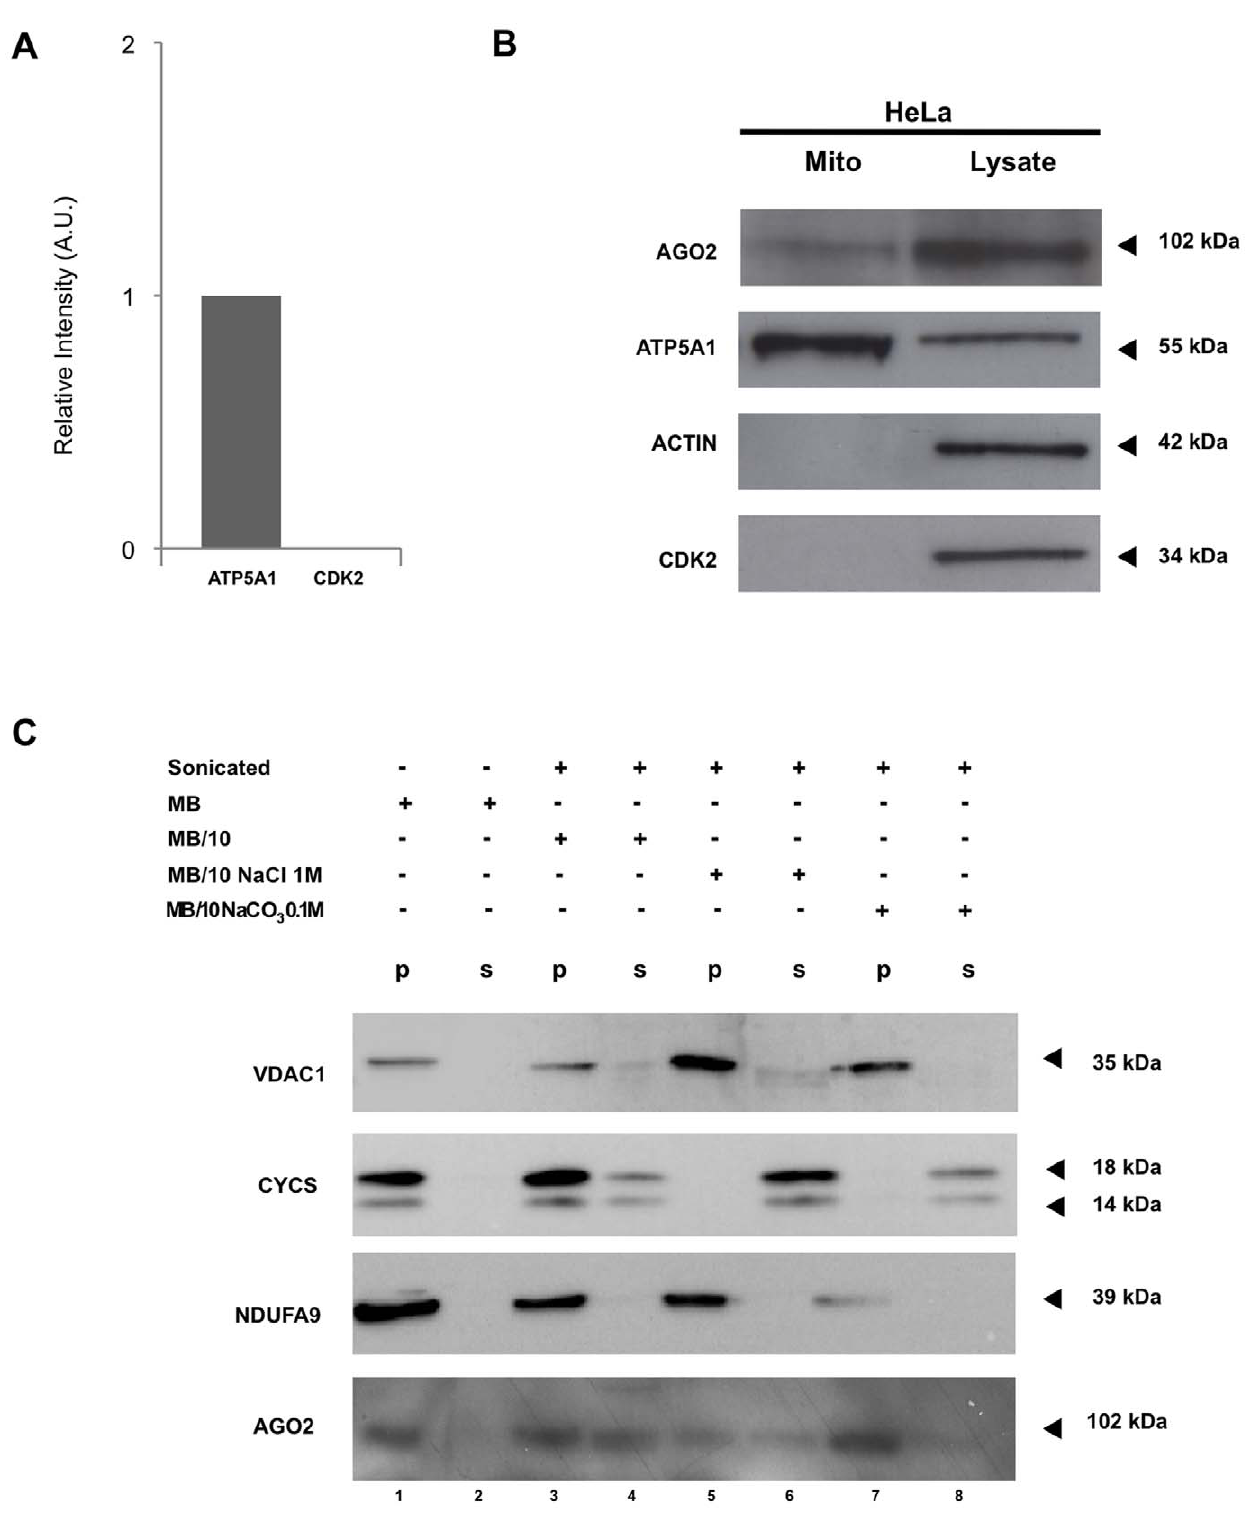
Figure 1. Novel localization of Argonaute 2 (AGO2) to human mitochondria. A. Purity assessment of mitochondrial fraction. Cyclin- dependent kinase 2 (CDK2) was assessed in the mitochondrial fraction by immunoblot analyses to check for nuclear and cytoplasmic contaminants relatively to mitochondrial protein ATP synthase subunit a (ATP5A1). The density of bands was measured using the ImageJ software and is represented as a relative intensity. Values are means 6 SD of three independent experiments. B. Western blot analysis of AGO2 in subcellular mitochondrial fraction from HeLa cells. AGO2 protein was detected using a rabbit polyclonal antibody anti-AGO2 in mitochondrial protein fraction (Mito) and total protein extracts (Lysate) from HeLa cells. ATP5A1 was used as a mitochondrial marker, actin as a cytosolic marker, and CDK2 as a nuclear/cytosolic marker. Representative image is shown of three independent experiments. C. Western blot analysis of AGO2 at mitochondrial